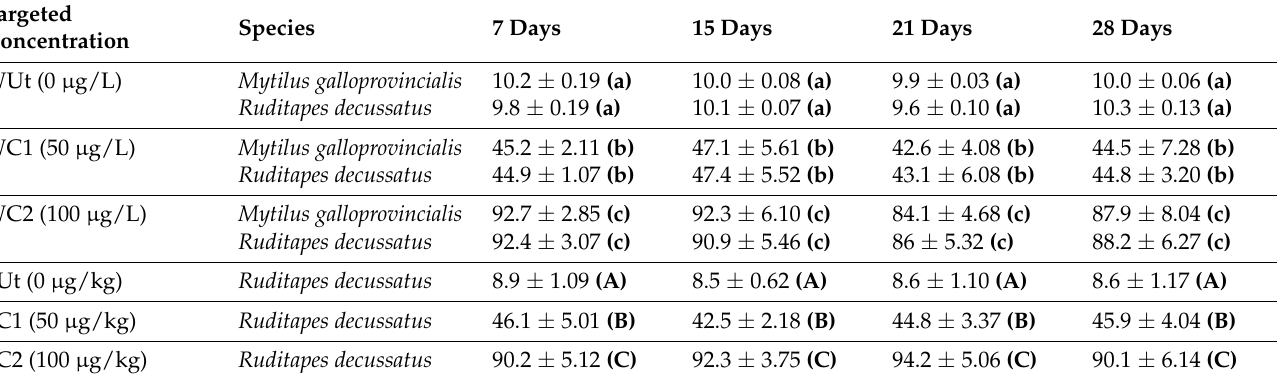
Table 1. Targeted and actual concentrations of phenanthrene measured in water and sediment where two bivalve species ( Mytilus galloprovincialis and Ruditapes decussatus ) were reared and exposed to an Untreated control (Ut) and two concentrations of phenanthrene in water [50 µ g/L (WC1) and 100 µ g/L (WC2)] and sediment [50 µ g/kg (SC1) and 100 µ g/kg (SC2)] for 28 days. Different letters (a, b, c, A, B, and C) indicate significant differences with the correspondent untreated controls, represented by ‘a’ for Mytilus galloprovincialis and ‘A’ for Ruditapes decussatus ( n = 3, log -transformed data, Tukey’s HSD test: p <